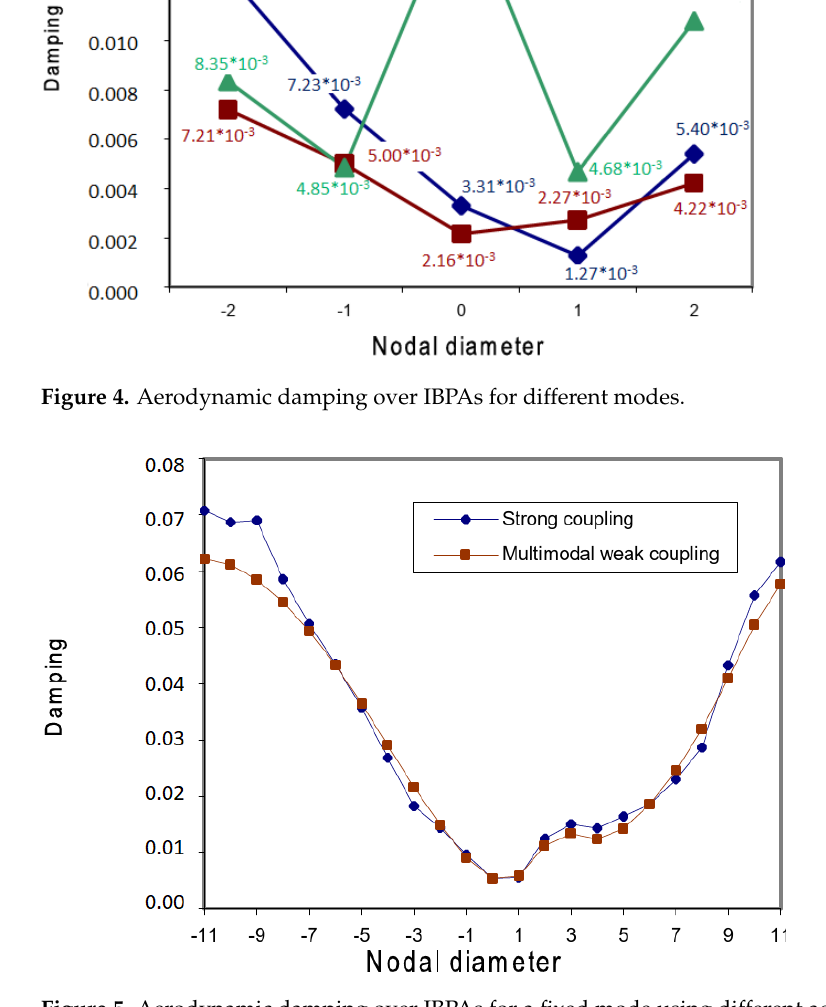
Figure 5. Aerodynamic damping over IBPAs for a fixed mode using different aerodynamic